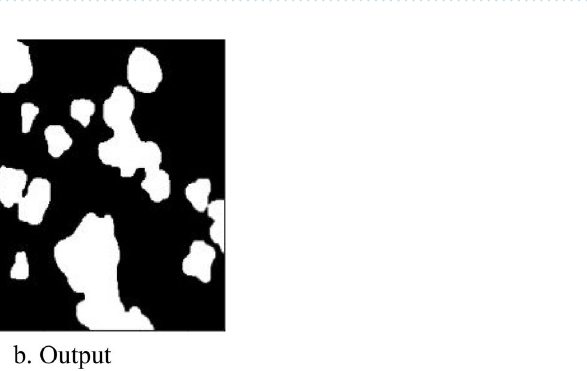
Figure 8. Input and Output of the U-Net. The inputs of the U-Net are the original, hemoglobin, and melanin images obtained from the preprocessing step. The output of the U-Net is a single masked